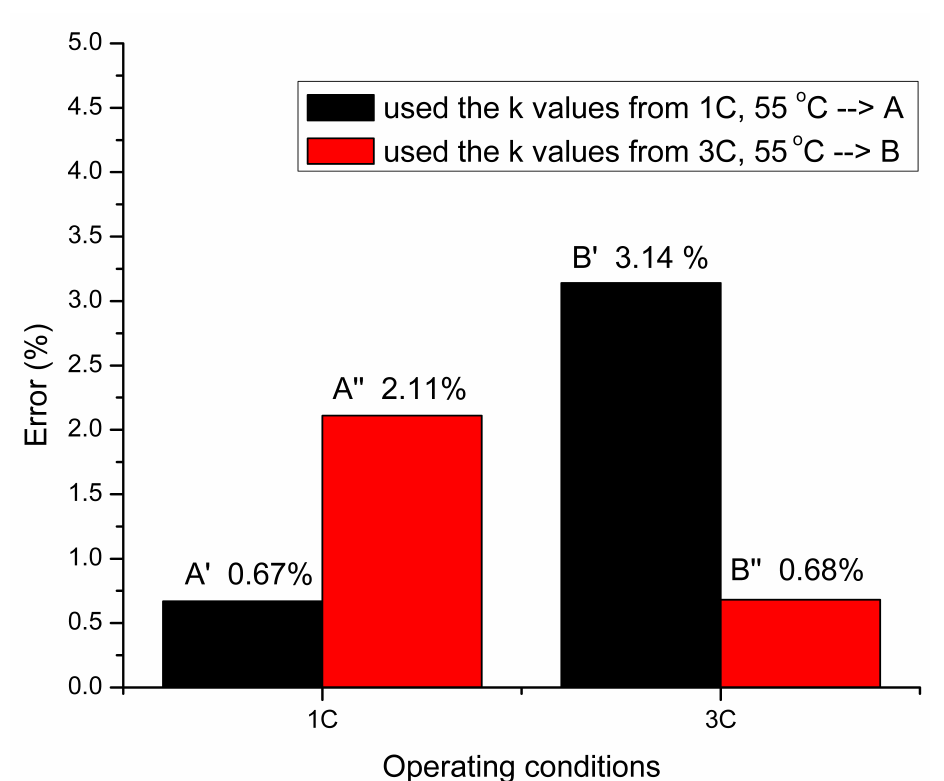
Figure 5. The estimation error between di ff erent discharge current under 55 ◦ C. % value on top of the bar represents the % error in estimation.